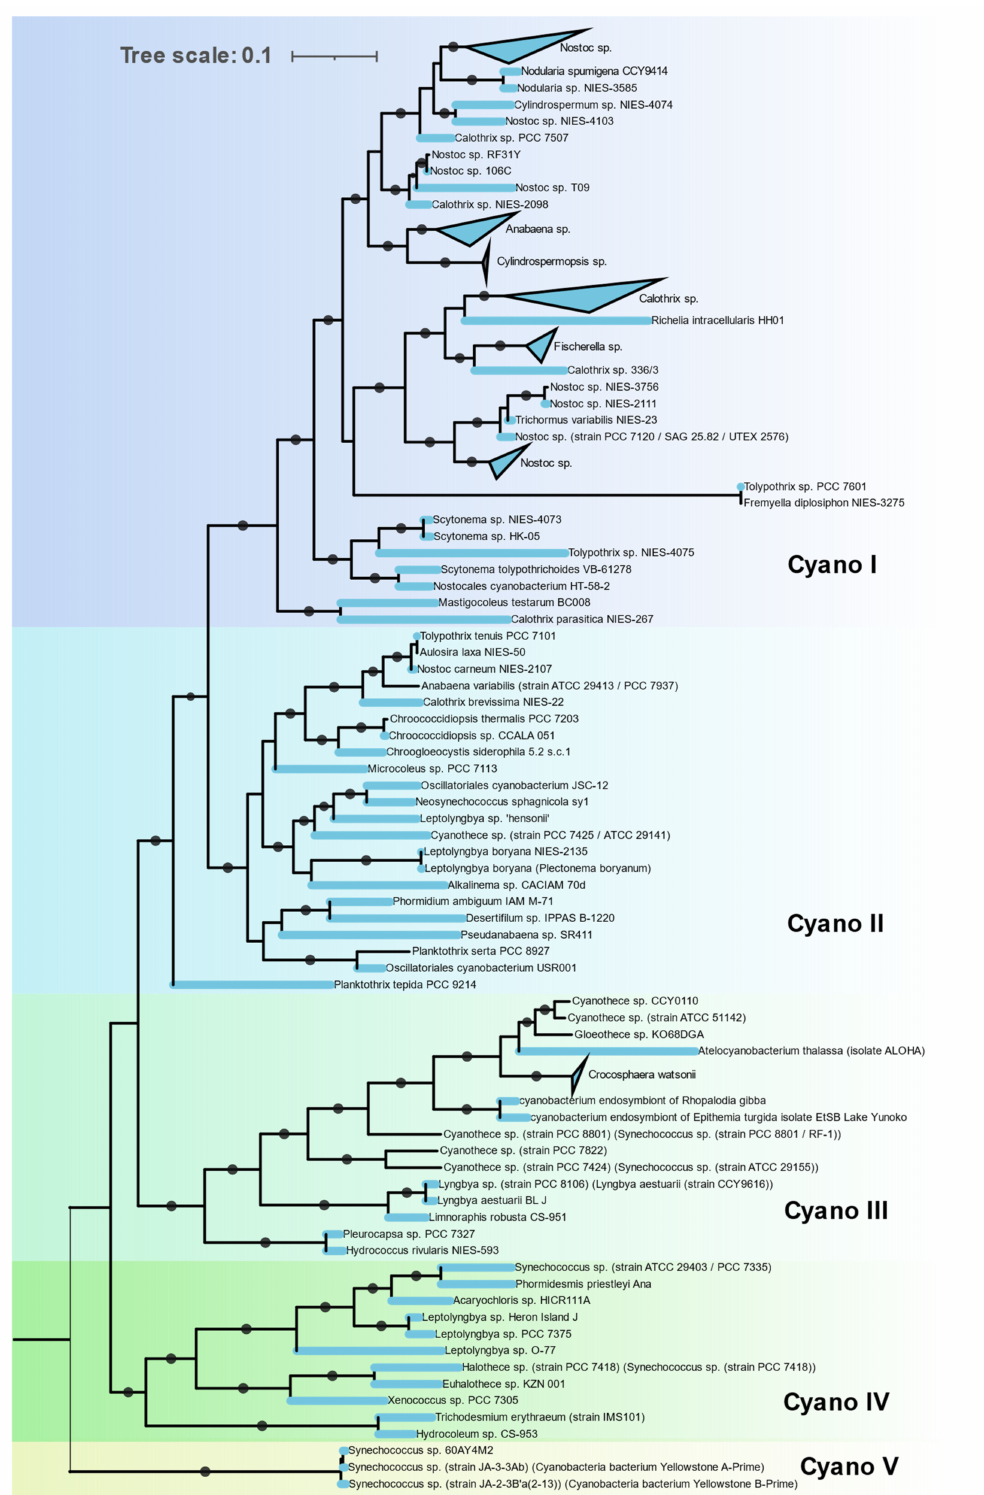
Figure 7. Phylogenetic relationship among Cyanobacteria in Cluster IC of the Concatenated NifHDKENB tree obtained by